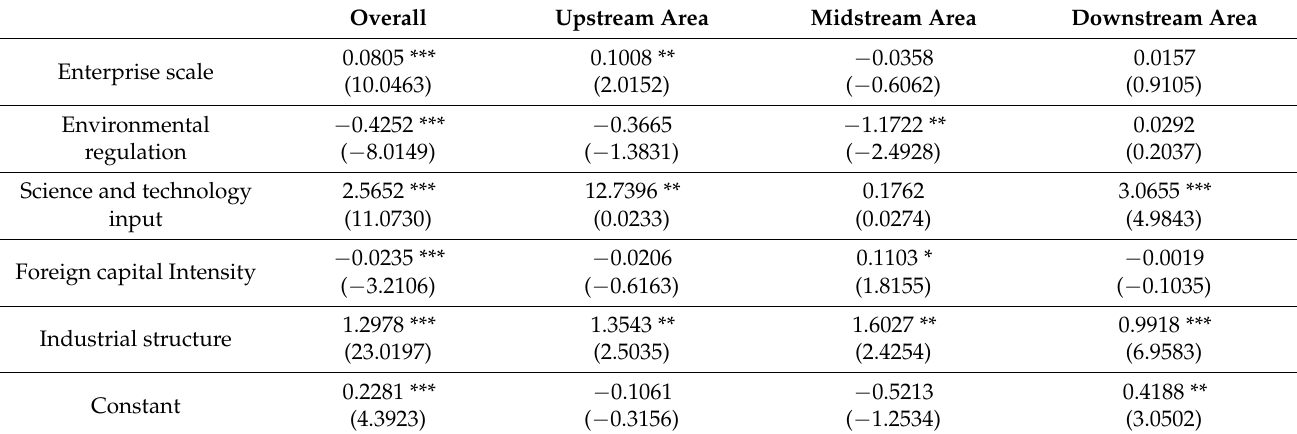
Table 4. Regression results of influencing factors of green development efficiency of the paper industry in Yangtze River Economic